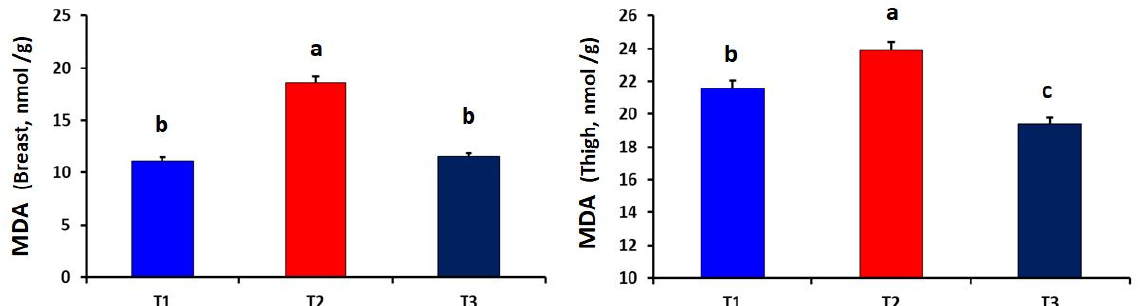
Figure 1. Effect of dietary curcumin supplementation on the levels of malondialdehyde (MDA) in the breast and thigh muscles of heat-stressed broiler chickens ( p = 0.001 and 0.015, respectively). a,b,c Values within a row with different superscripts differ